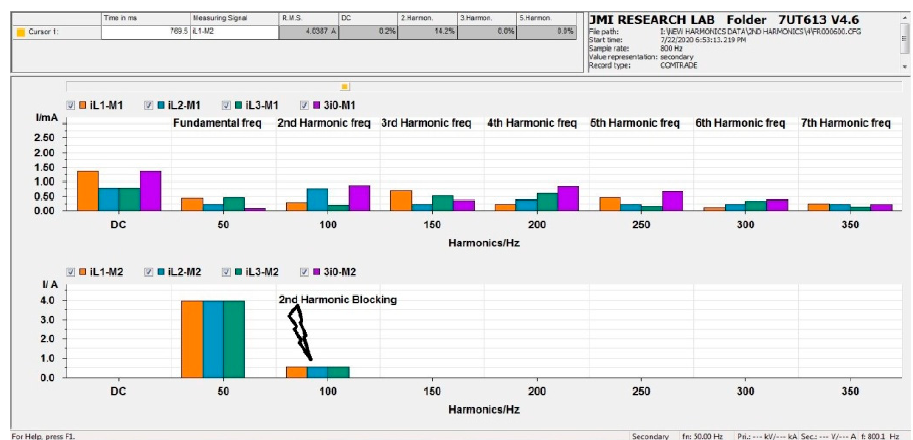
Figure 16. 2nd HB at 3000 mA Rated current & 20% of Inrush current condition.